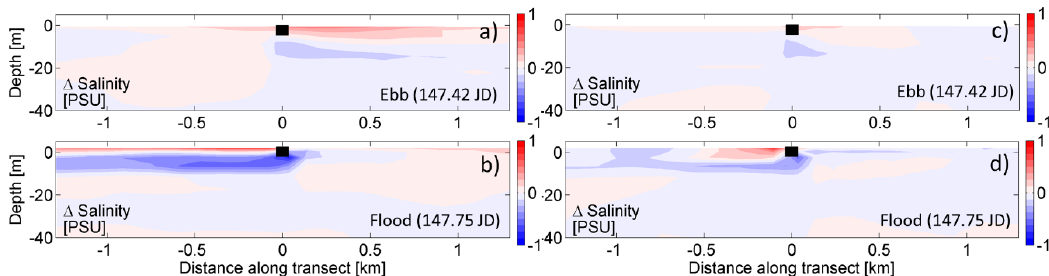
Figure 19. ( a , b ) Salinity difference of baseline scenario with HCB relative to test 1 without HCB during peak ebb and flood; ( c , d ) velocity difference of baseline scenario with HCB relative to test 2 with draw span open during ebb and flood. (Typical spring tide on 27 April 2017).